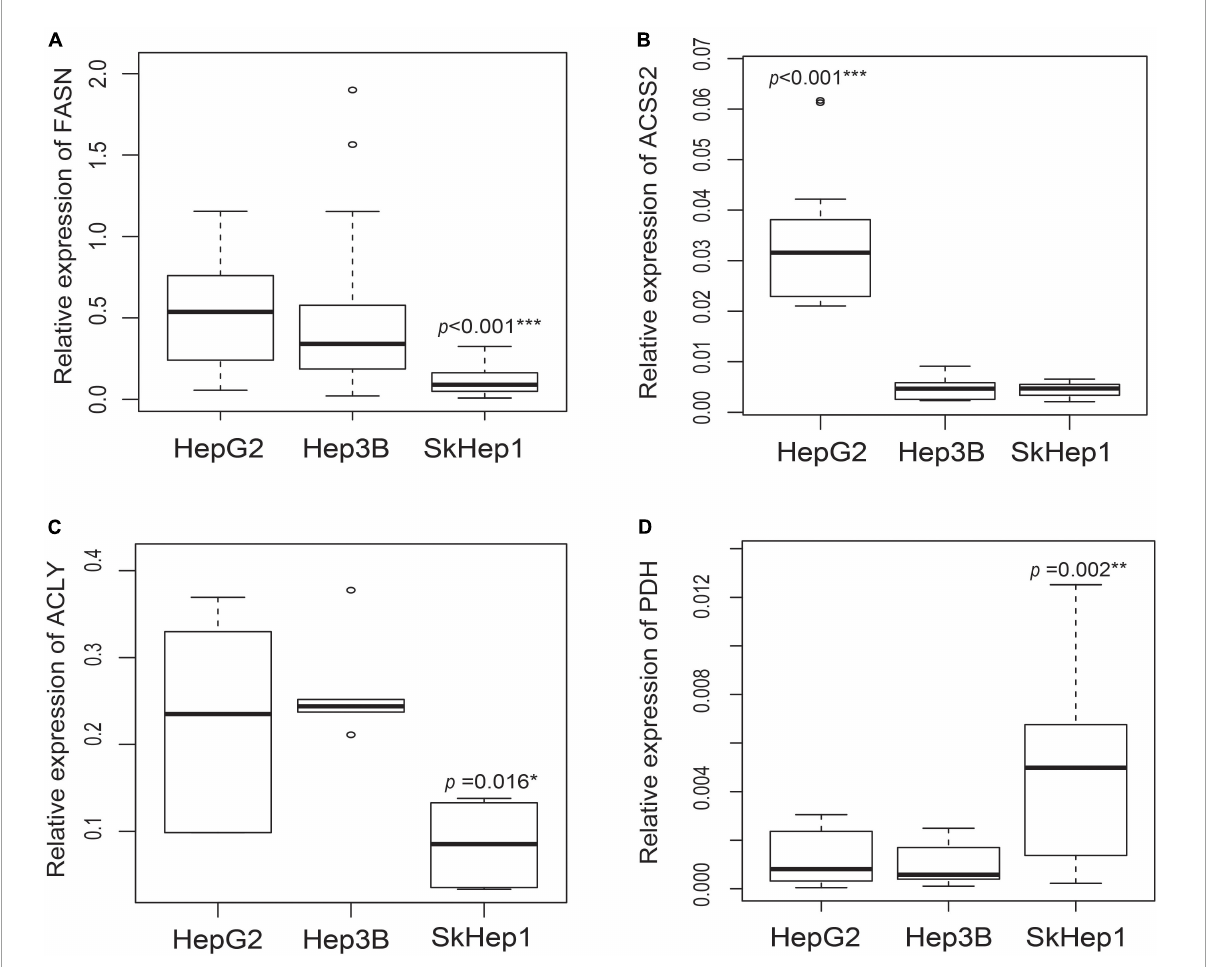
FIGURE1 Gene expression of lipogenic enzymes and glycolysis-associated enzymes in three HCC cell lines. Gene expression analysis in three lipogenic enzymes through real-time PCR revealed that (A) FASN expression is significantly lower in SkHep1 cells than in Hep3B and HepG2 cells (Kruskal–Wallis test *** p < 0.001; n = 24 for each cell line), (B) ACSS2 expression is significantly higher in HepG2 cells than in Hep3B and SkHep1 cells (Kruskal–Wallis test *** p < 0.001; n = 12 for each cell line), and (C) ACLY expression (Kruskal–Wallis test * p = 0.016; n = 6 for each cell line) is significantly lower in SkHep1 cells than in Hep3B and HepG2 cells. (D) The expression of glycolysis-associated enzyme PDH in SkHep1 cells is significantly higher than that in Hep3B and HepG2 cells (Kruskal–Wallis test ** p = 0.002; n = 15 for each cell line). We summarized all the measurements as box-plots that label 25, 50, and 75% quantiles in the boxes with whiskers presenting at most 1.5 × interquartile